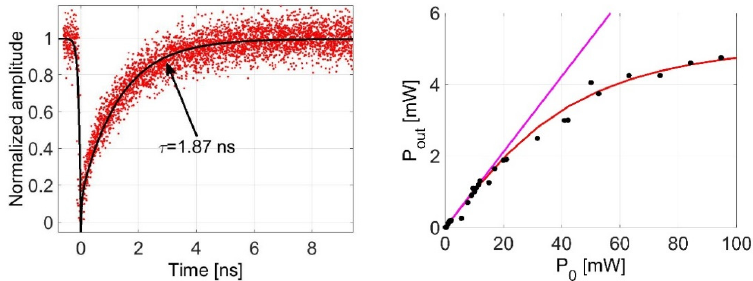
Figure 3. ( Left ) Free carrier recovering time experimental trace ( P 0 = 10 W); and ( Right ) example of the transmission curve used to estimate α FC ( L = 2.26 cm); black circles are the experimental data, the red trace is the fitting function and the purple line represents the theoretical curve without TPA (two-photon absorption) and FCA (Free Carrier Absorption) effects [28].